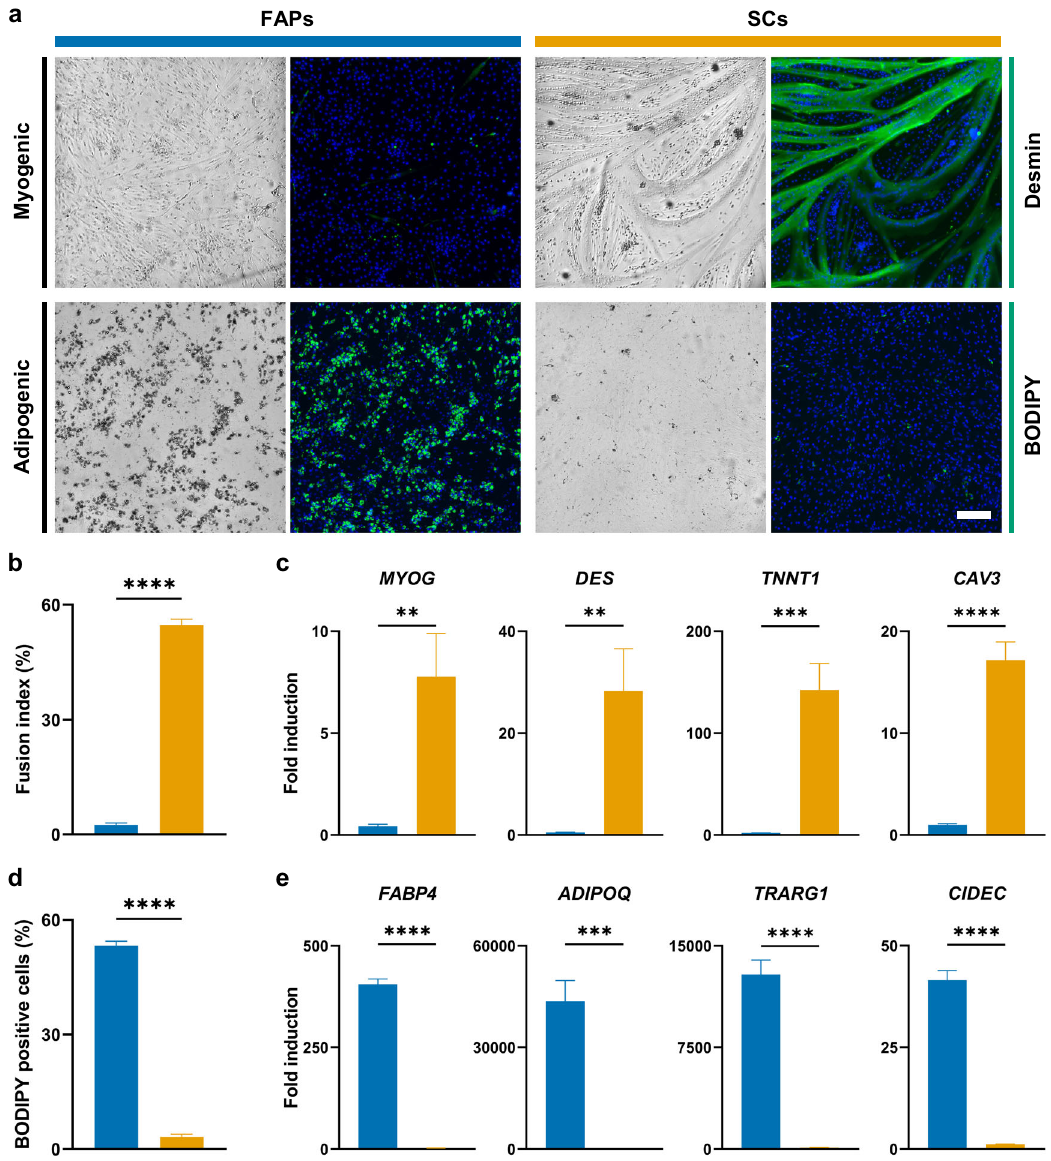
Fig. 3 Myogenic and adipogenic differentiation of bovine FAPs and SCs. a Bright fi eld and immuno fl uorescence microscopy images of myogenic (top) and adipogenic (bottom panel) differentiation of FAPs and SCs after 96 h (for myogenic) and 14 days (for adipogenic) differentiation in 2D culture vessels, respectively. Green = desmin (myogenic) or BODIPY (adipogenic), blue = Hoechst, scale bar = 200 µm. b Quanti fi ed fusion indices of myogenic samples in a . c Expression of muscle-related genes in FAPs and SCs after 96 h of myogenic differentiation, measured by RT-qPCR. Data was normalised against SC control (0 h). d Quanti fi cation of BODIPY positive cells in adipogenic samples in a . e Expression of adipogenesis-related genes in FAPs and SCs after 14 days of adipogenic differentiation, measured by RT-qPCR. Data was normalised against FAP control (Day 0). All numerical data is shown as mean ± sd ( n = 3); P -values: * P ≤ 0.05; ** P ≤ 0.01; *** P ≤ 0.001; **** P ≤